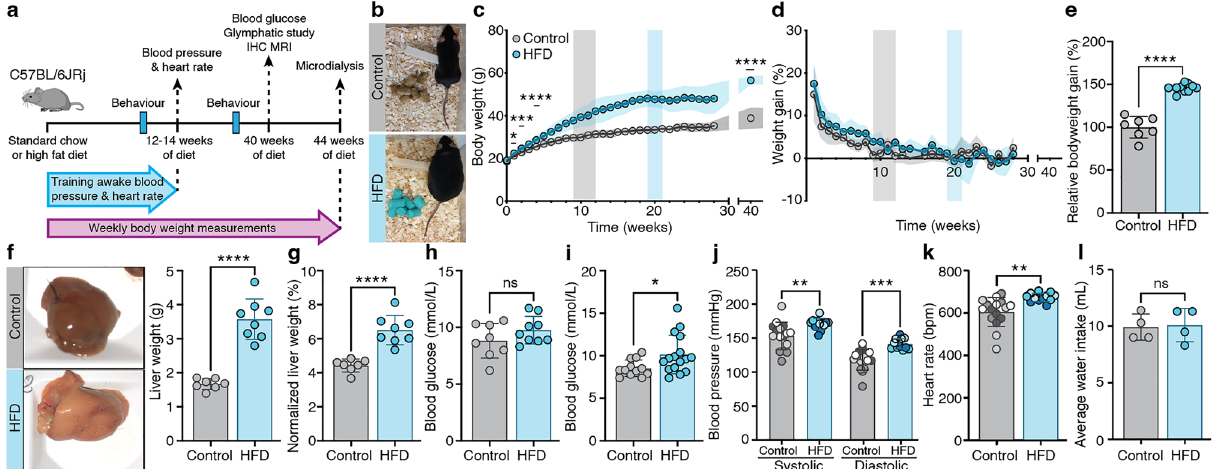
Figure 1. Long-term high-fat diet (HFD) causes severe obesity in C57BL/6JRj mice. ( a ) Schematic timeline of experimental setup. ( b ) Representative control (standard chow fed) and high-fat diet (HFD) mouse